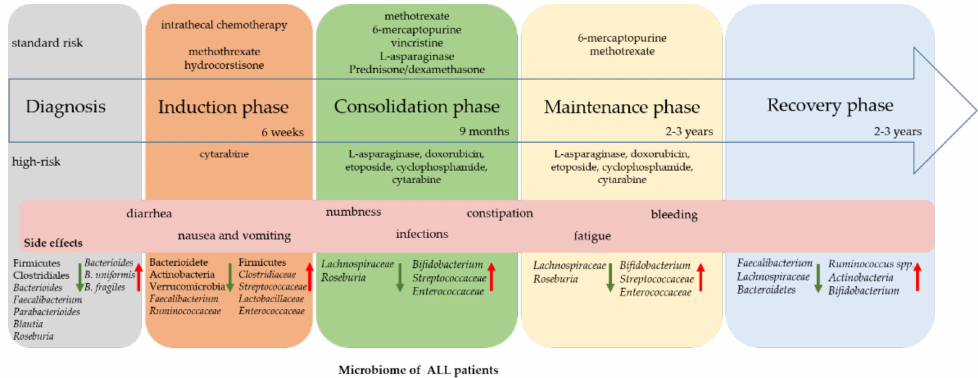
Figure 1. Microbial shift and side effects during therapy. During cancer therapy microbial composition shifts depending on medical treatment. Up (red arrow) and downregulated (green arrow) bacteria are listed from time-point of diagnosis, induction, consolidation, maintenance, and recovery phase. Side effects occur between all phases and cannot be assigned to a specific time. Therapy is divided into standard and high-risk with differences in therapeutical